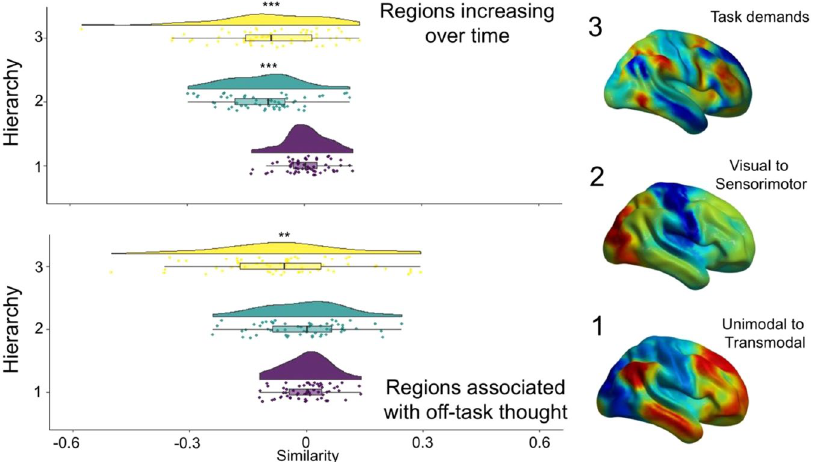
Figure 2. The brain dynamics associated with the passage of time can be understood as changes along neurocognitive functional hierarchies. The maps representing each participants’ neural correlation with time were compared to previously defined functional hierarchies 11 . Brain regions that changed over time were significantly related to the hierarchies representing task-demands as well as modality (top). When participants said they were having off-task thoughts neural patterns were similar to patterns seen in the absence of external demands